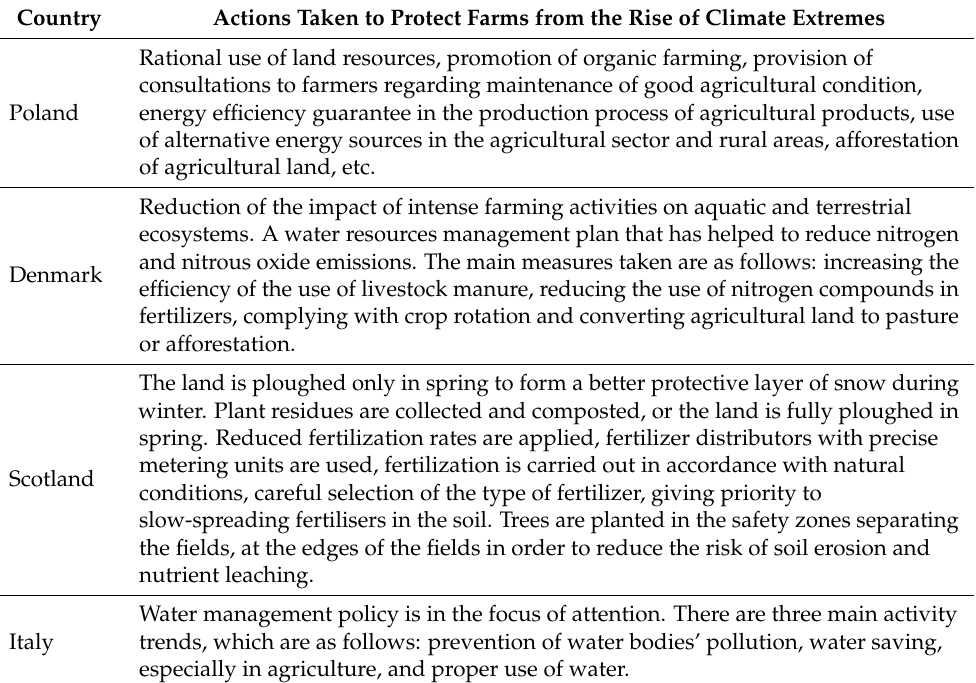
Table 4. Actions taken by foreign countries to protect farms from the rise of climate